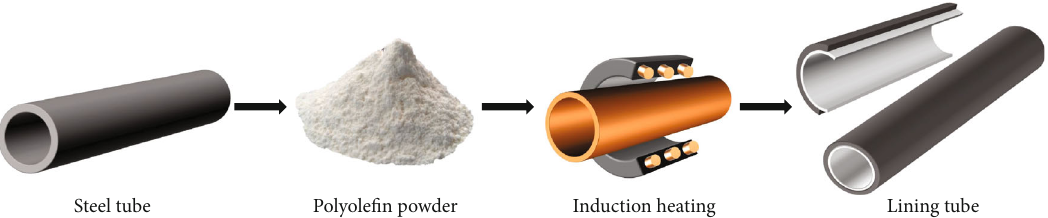
Figure 1: Pipeline lining process sheet. The principle is to fi ll the polyole fi n into the pipe and then heat and solidify it on the inner